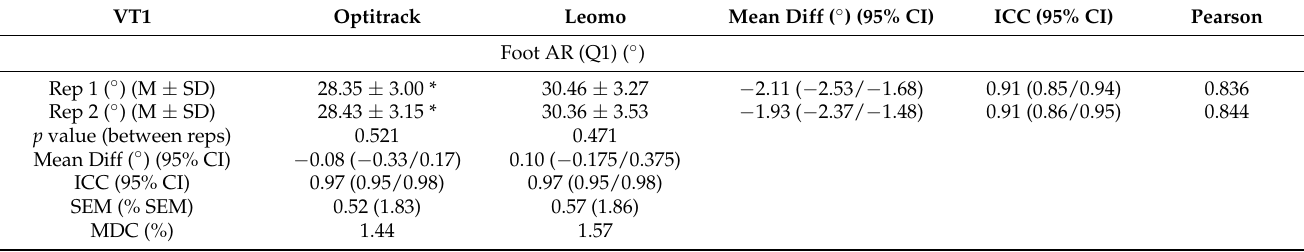
Table 3. Validity and reliability of the Leomo system with Optitrack system for the assessment of angular parameters during pedaling cycle at